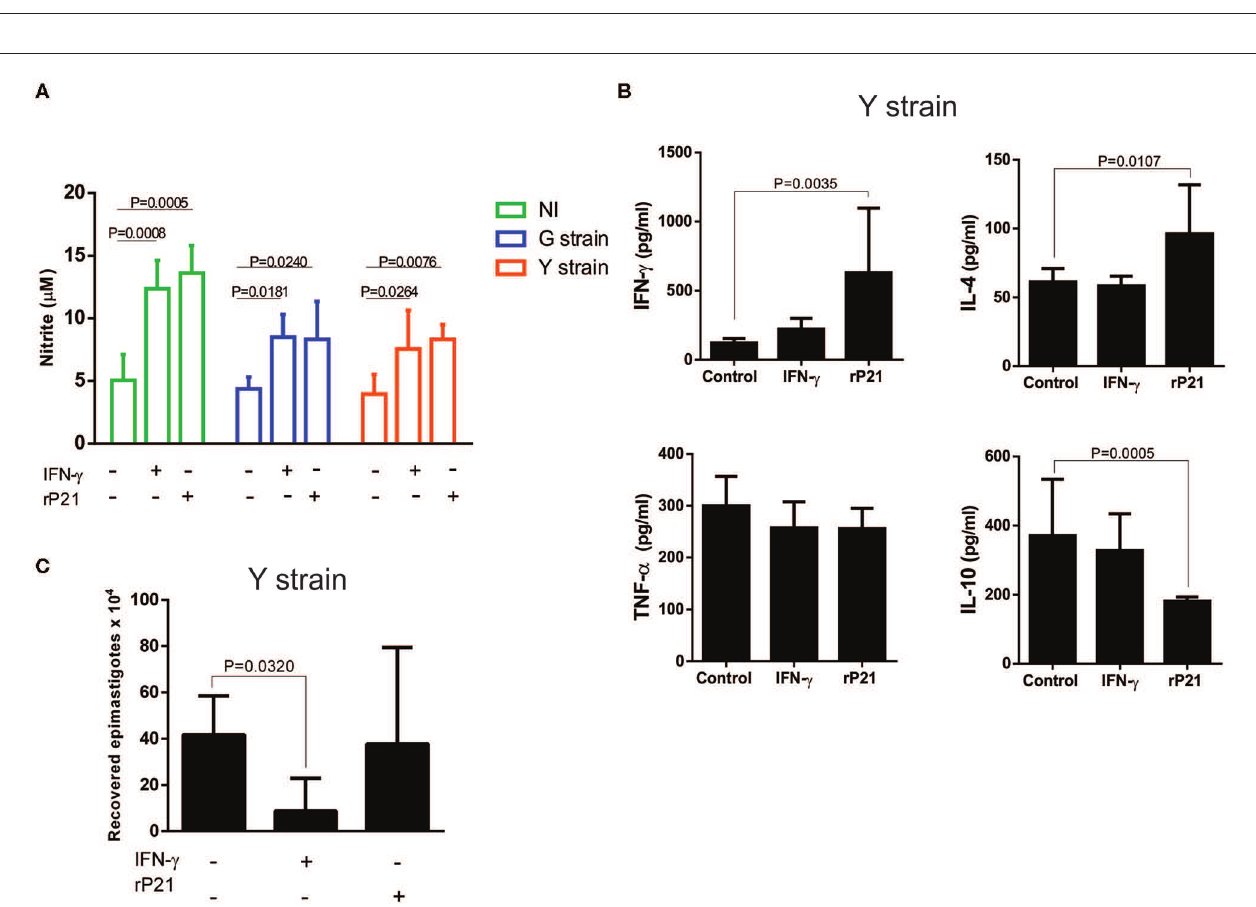
FIGURE 1 | confirmed the enhancement of actin polymerization when C2C12 cells were treated with rP21. (E–H) rP21 leads to impaired multiplication of the G (E) and Y (G) strains. Parasites (green) are labeled with FITC – conjugated antibody and F-actin with TRITC-phalloidin (red). Representative images of T. cruzi and F-actin staining are shown (F) G strain and (H) Y strain. (I,J,L) FACS shows increased actin polymerization (I) associated with lower multiplication of the Y strain of T. cruzi (J) when rP21 treatment was performed. Representative images are shown (L) . Data are expressed as the mean ± standard deviation (SD) of experiments performed in